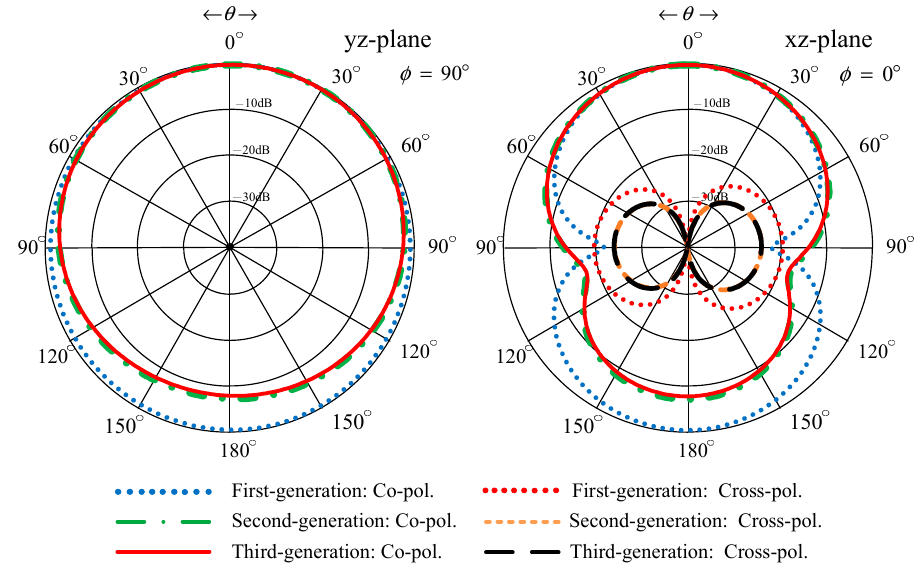
Figure 9. Simulated antenna gains of the first-, second-, and third-generation antenna schemes.